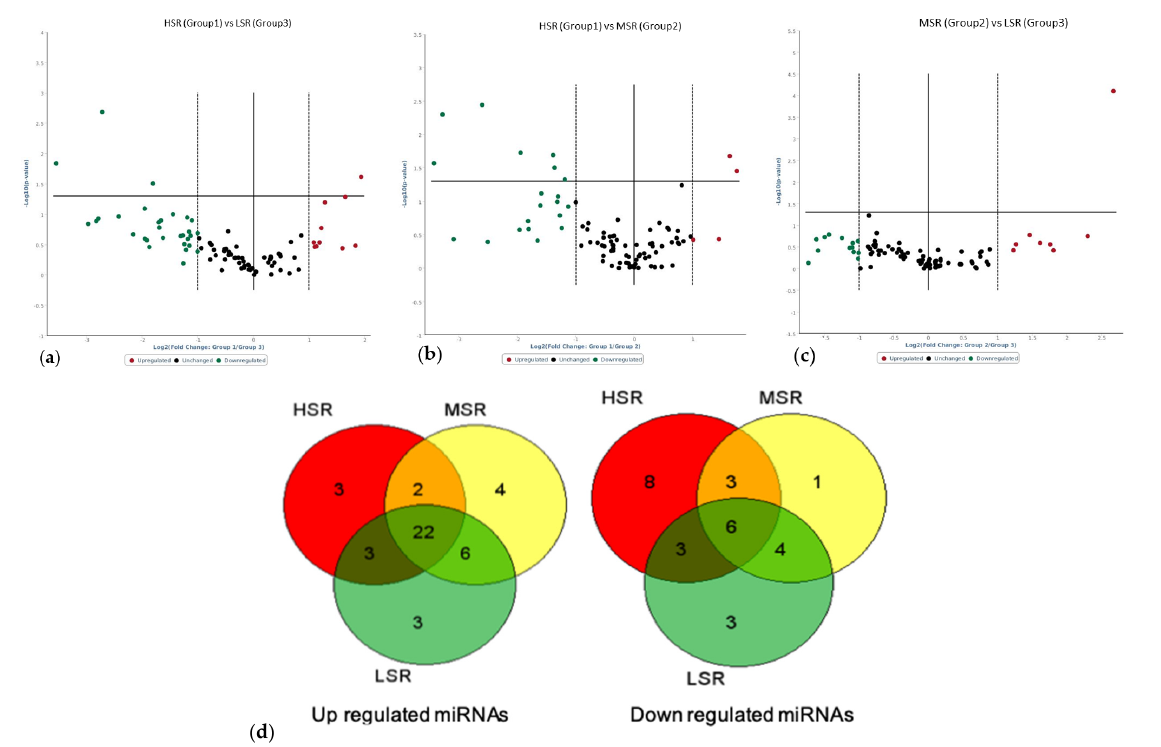
Figure 3. Volcano plots of differentially expressed miRNAs 4 h post-LPS (400 ng/kg) i.v. administration from variable stress-responding groups of sheep: ( a ) HSR vs. LSR, ( b ) HSR vs. MSR, and ( c ) MSR vs. LSR. ( d ) Venn diagram of genes commonly upregulated and downregulated in all groups. Number digits are numbers of miRNAs that are up/down